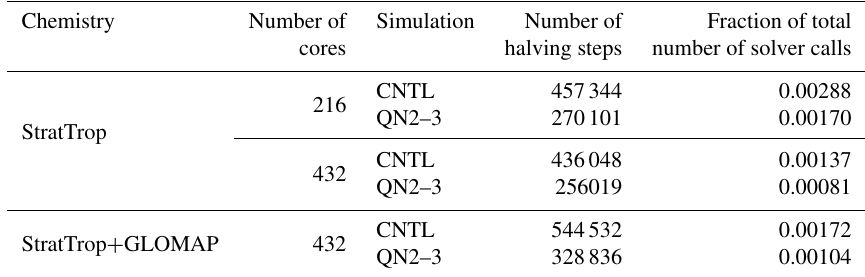
Table 6. Number of times that the solver needed to halve the time step in order to avoid divergences or wild oscillations over 1 year of